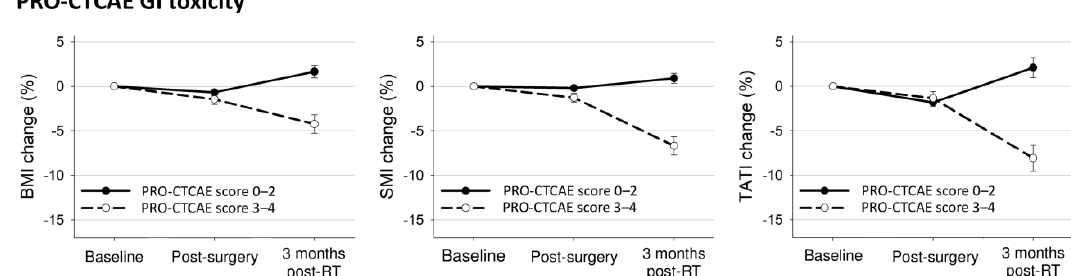
Figure 3. Mean changes with 95% confidence interval bars in body composition indexes from baseline to 3 months after treatment completion according to any PRO-CTCAE GI toxicity.